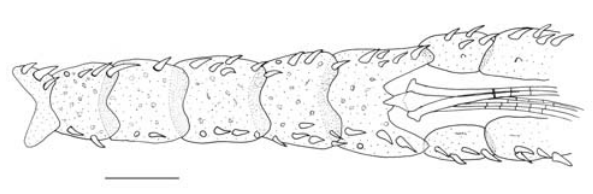
Fig. 5. Ventral midline plates in Scoloplax baskini , INPA 28650, paratype, 16.1 mm SL. Ventral view, anterior toward left.